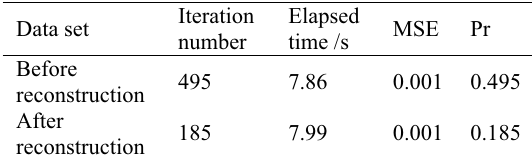
Table 1. Performance comparison before and after phase space